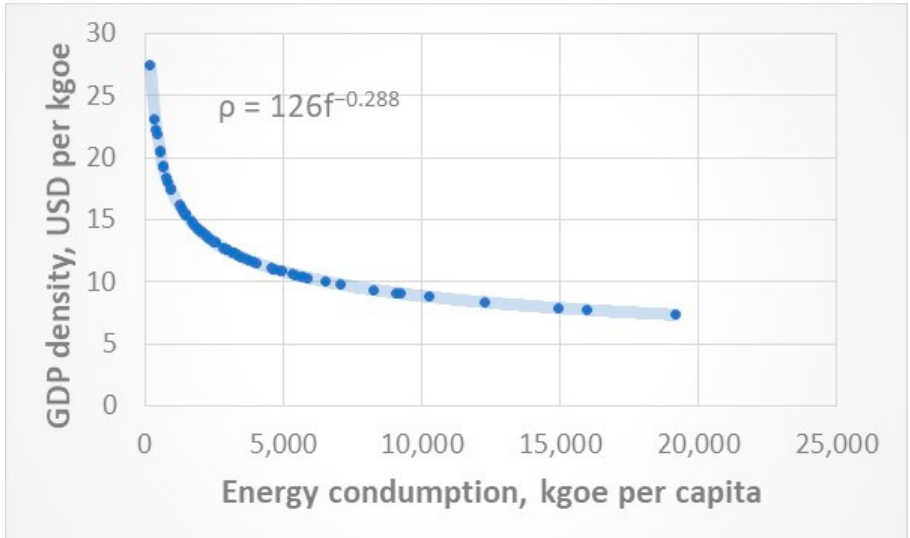
Figure 6. The relationship between the energy density of GDP and the average per capita consumption of energy resources in 74 national economies (2016). Source: calculated by the authors on the basis [51,55,56,58].